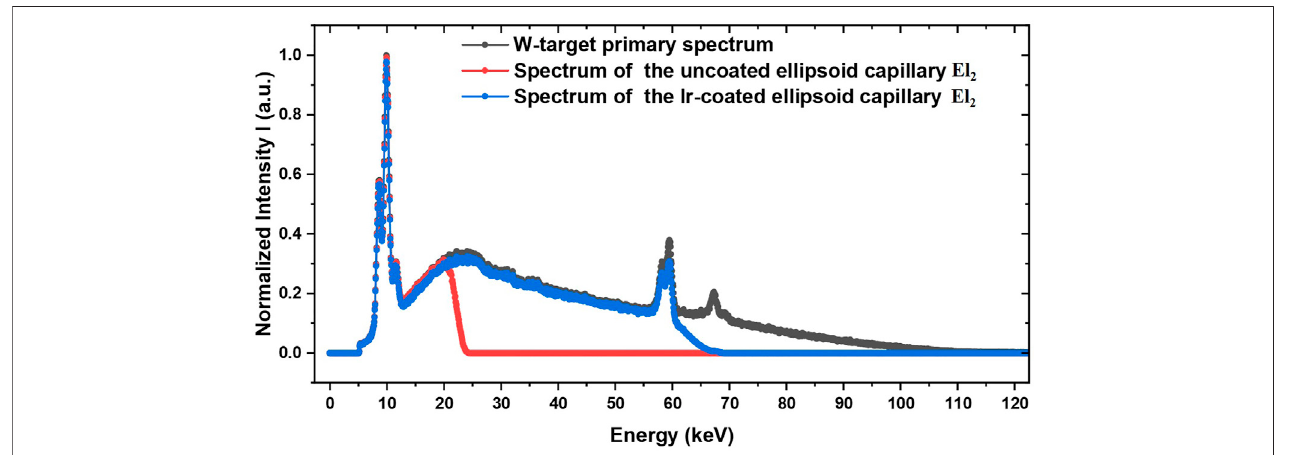
FIGURE 10 | Normalized spectrums of the re fl ected X-rays of the ellipsoid capillary El 2 . The gray curve is the W-target primary normalized spectrum. The red and blue curves are the normalized re fl ected energy spectrums of the uncoated and Ir-coated ellipsoid capillaries, respectively.